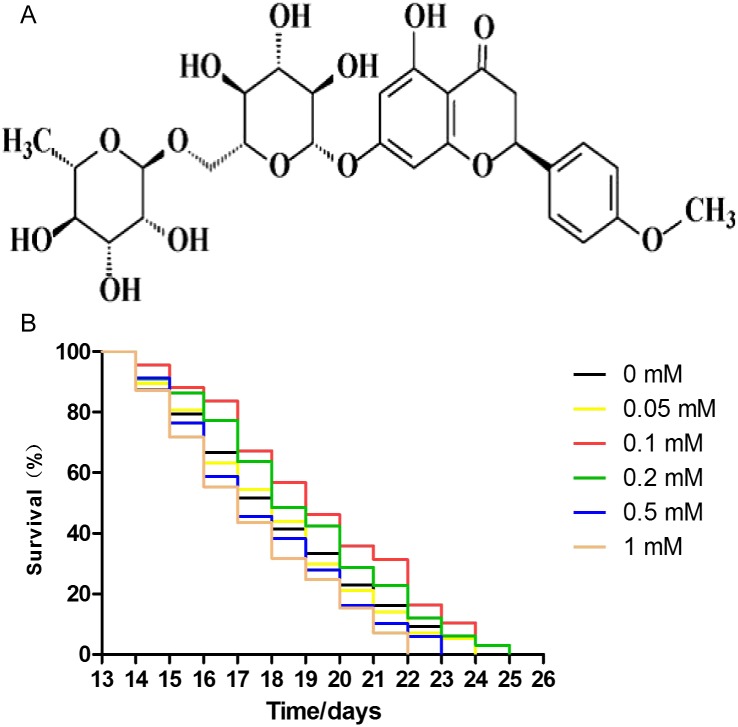
Didymin extended the lifespan of C. elegans wild-type nematodes under normal culture conditions.The chemical structure of didymin (A) is shown. (B) The adult worms were treated with didymin (0.05, 0.1, 0.2, 0.5, and one mM) or 0.2% DMSO (vehicle control). The greatest effect of didymin on the lifespan of nematodes occurred at 0.1 mM (n > 100, p < 0.001).